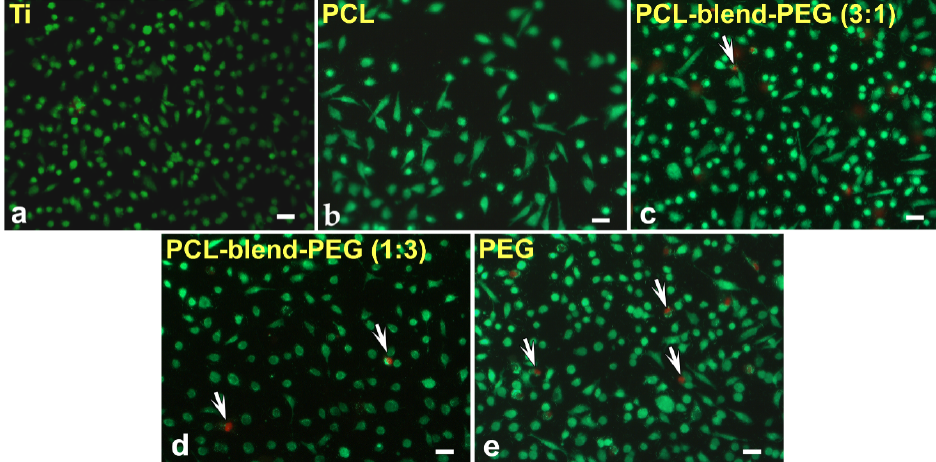
Figure 10. Cell viability assays of endothelial cells grown on PCL-blend-PEG coatings deposited by DC method. Living (green) and still attached dead (red) cells (marked with arrows) were detected by fluorescence microscopy using calcein AM and ethidium homodimer-1, respectively (20 × ; scale bar = 50 µ